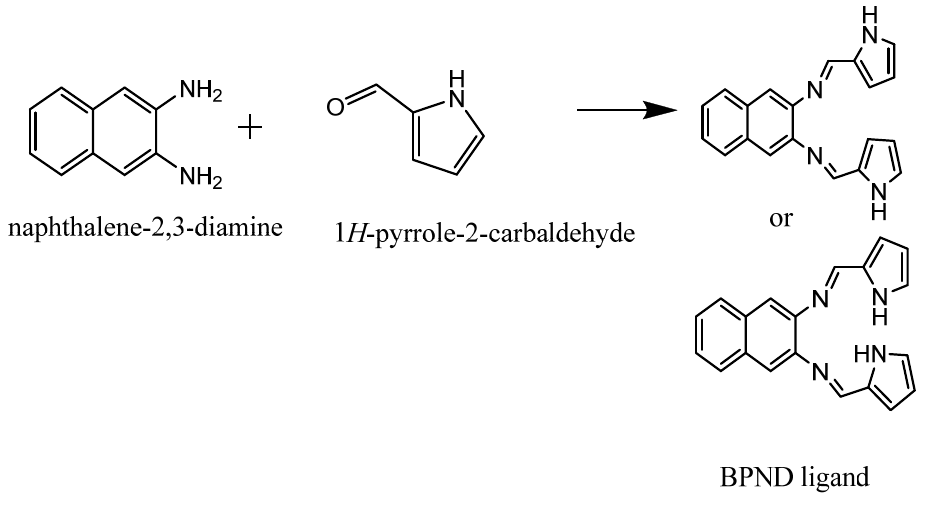
Scheme 1. Schiff base ligand synthesis